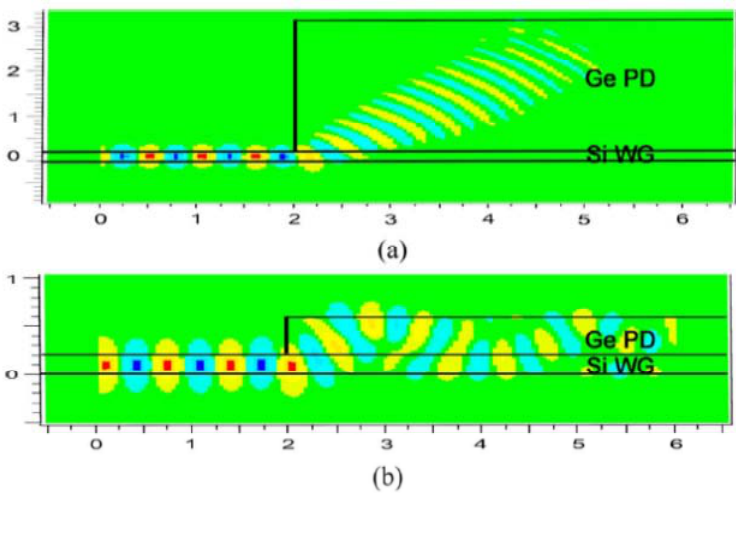
Figure 10. 3D finite difference time domain (FDTD) simulation of photon propagation in bottom-waveguide-coupling structures ( a ) 3.0 μ m vs. ( b ) 0.4 μ m thick Ge active region